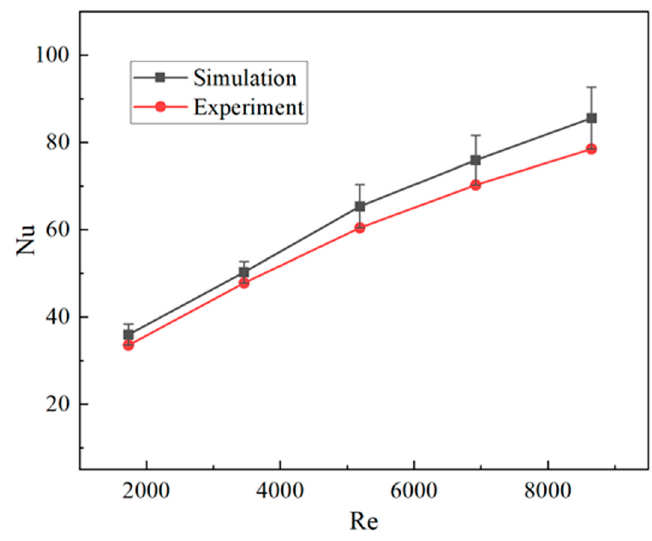
Figure 4. Model validation by comparing with experimental results [30].